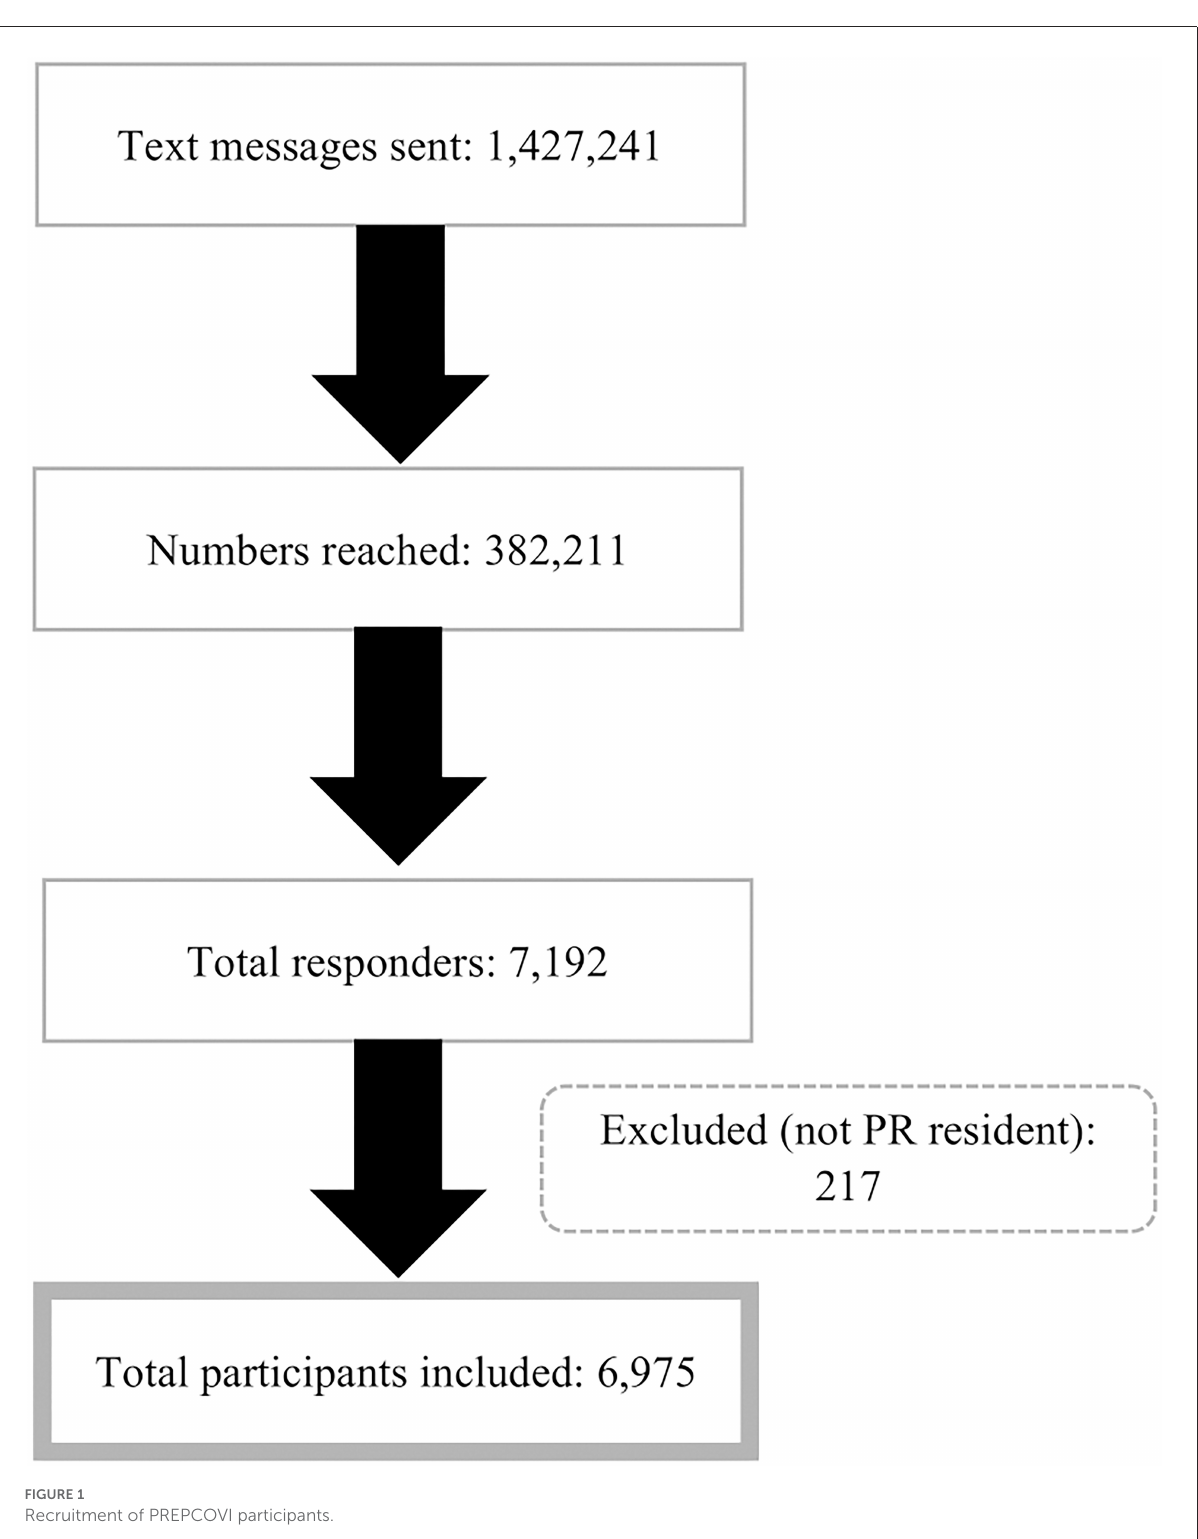
FIGURE1 Recruitment of PREPCOVI